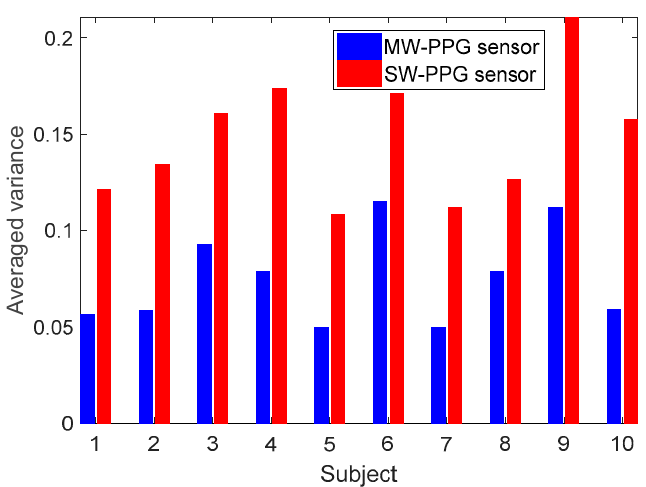
Figure 9. Averaged variation of 10 subjects. Red bar is derived from the reference signal-wavelength photoplethysmography (SW-PPG) sensing device, whereas blue bar is derived from the developed MW-PPG sensing device.